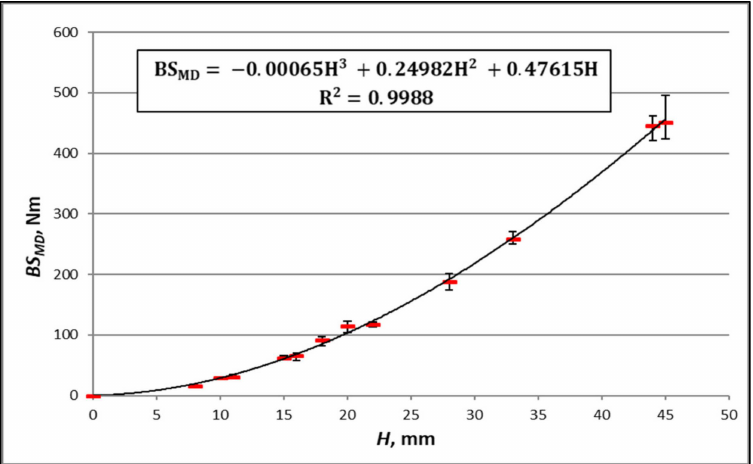
Figure 10. Measurements of BS MD boards TL135/TL135/TL135 with core cell size of D = 15 mm and different